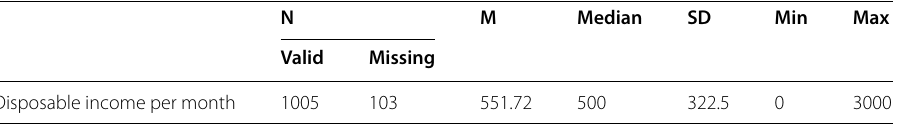
Table 4 Young adults’ disposable